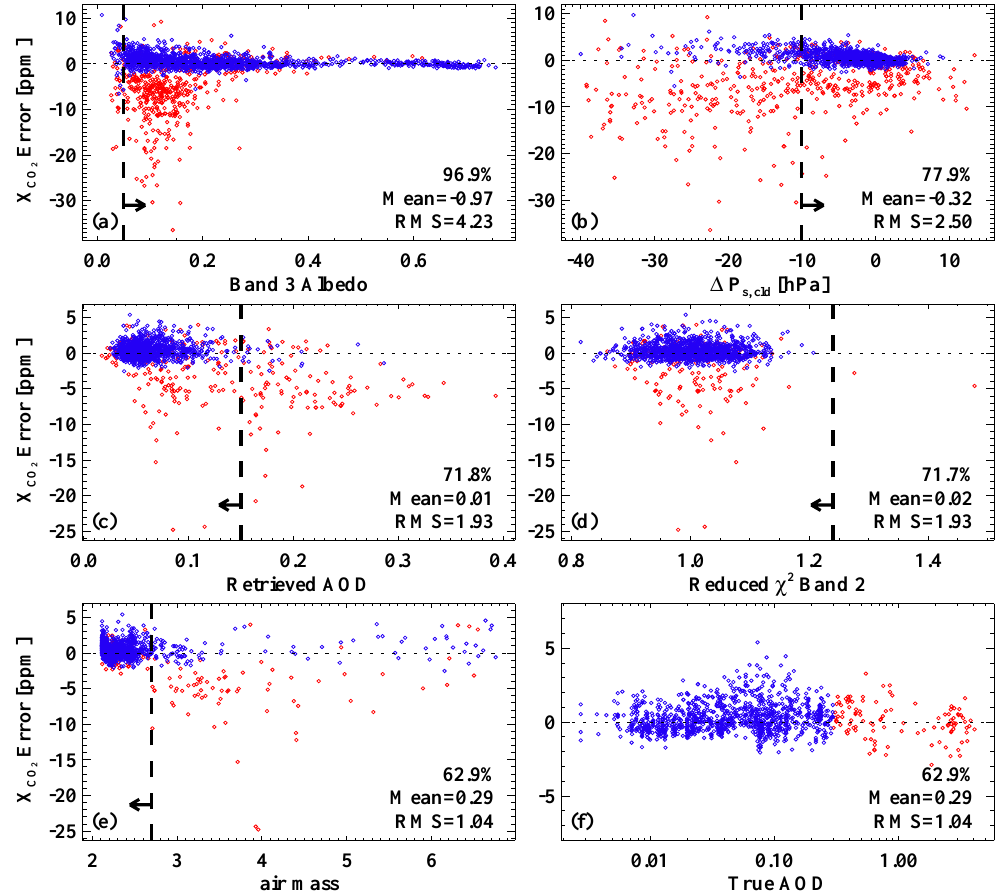
Fig. 9. Results from applying candidate quality-control filters to the X CO retrievals from test 5. Panels (a) through (e) show the X CO 2 error plotted versus a candidate filtering variable. Dashed vertical lines with arrows show the filter threshold value for each variable, if any. The values in the bottom-right of each panel give the percentage of soundings passing the filters applied cumulatively through that filter, as well as the mean and RMS X CO error (in ppm) of those soundings. Soundings in blue (red) have a true column AOD of less than (greater 2 than) 0.3. We stress that this display applies the filters cumulatively, though the final results are independent of order. Panel (f) shows the X CO error vs. true AOD for the filtered 2